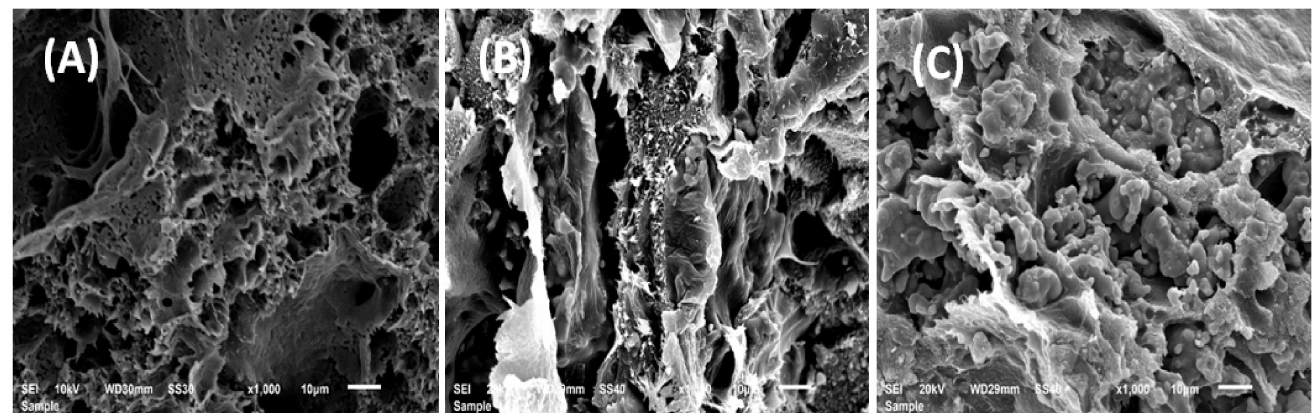
Figure 12. SEM images of the cross-section of ( A ) the PEVAL/PDVAL blend, ( B ) the PEVAL/PDVAL/ β -TCP50 and ( C ) PEVAL/PDVAL/ β -TCP70 composite specimens, zoomed at 1000 ×